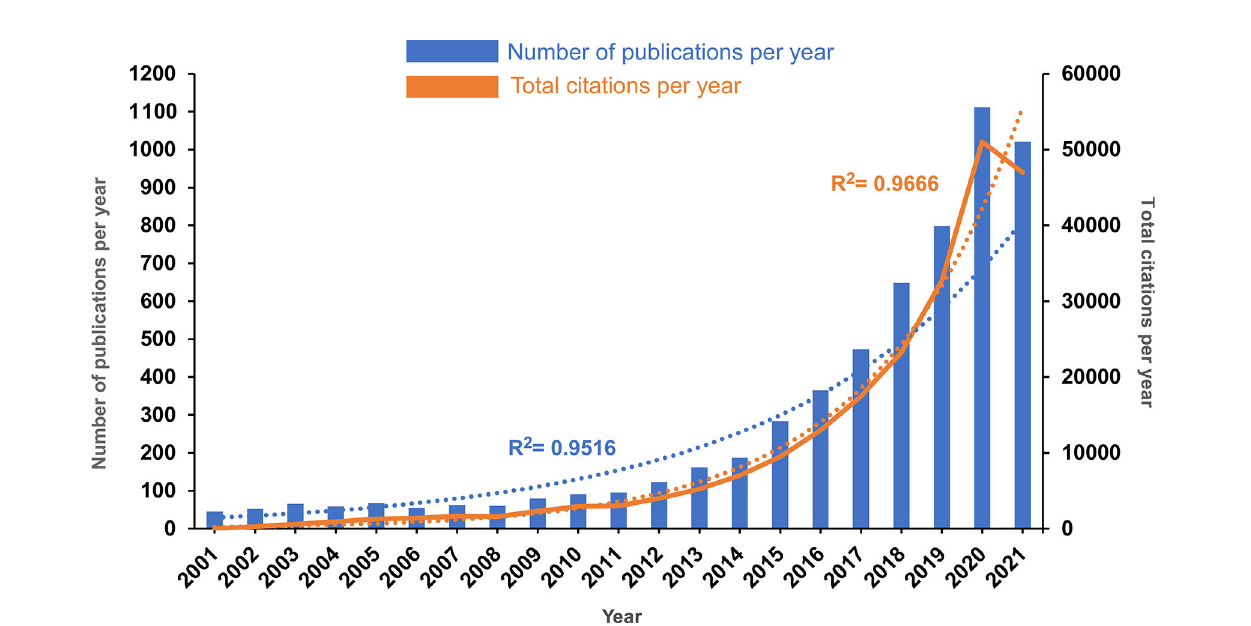
FIGURE 1 | The annual publication and annual citation trends in the past 20 years. The blue bars represent the number of publications per year, and the orange solid curve represents the total number of citations per year. The blue and orange dotted lines represent the trend- fi tted curves using exponential functions. The correlation coef fi cients (R 2 ) are displayed in the fi